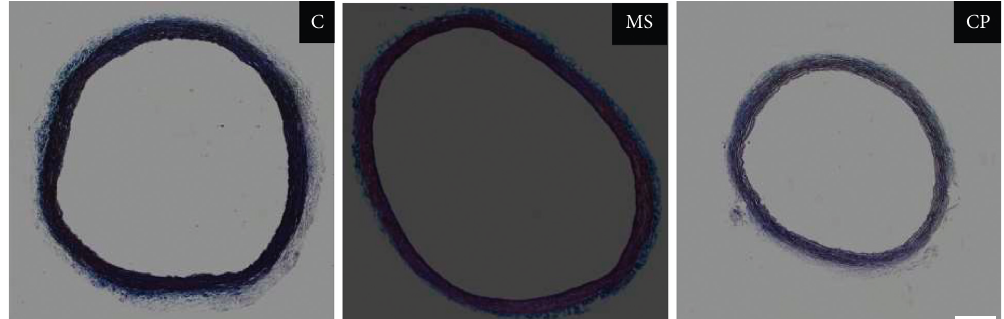
Figure 1: Representative images of the thoracic aortas stained with Masson’s trichrome in the rats from the control (C), metabolic syndrome (MS), and critical period (CP) conditions. MS rats ingested sucrose solution during six months; CP animals ingested sucrose solution during